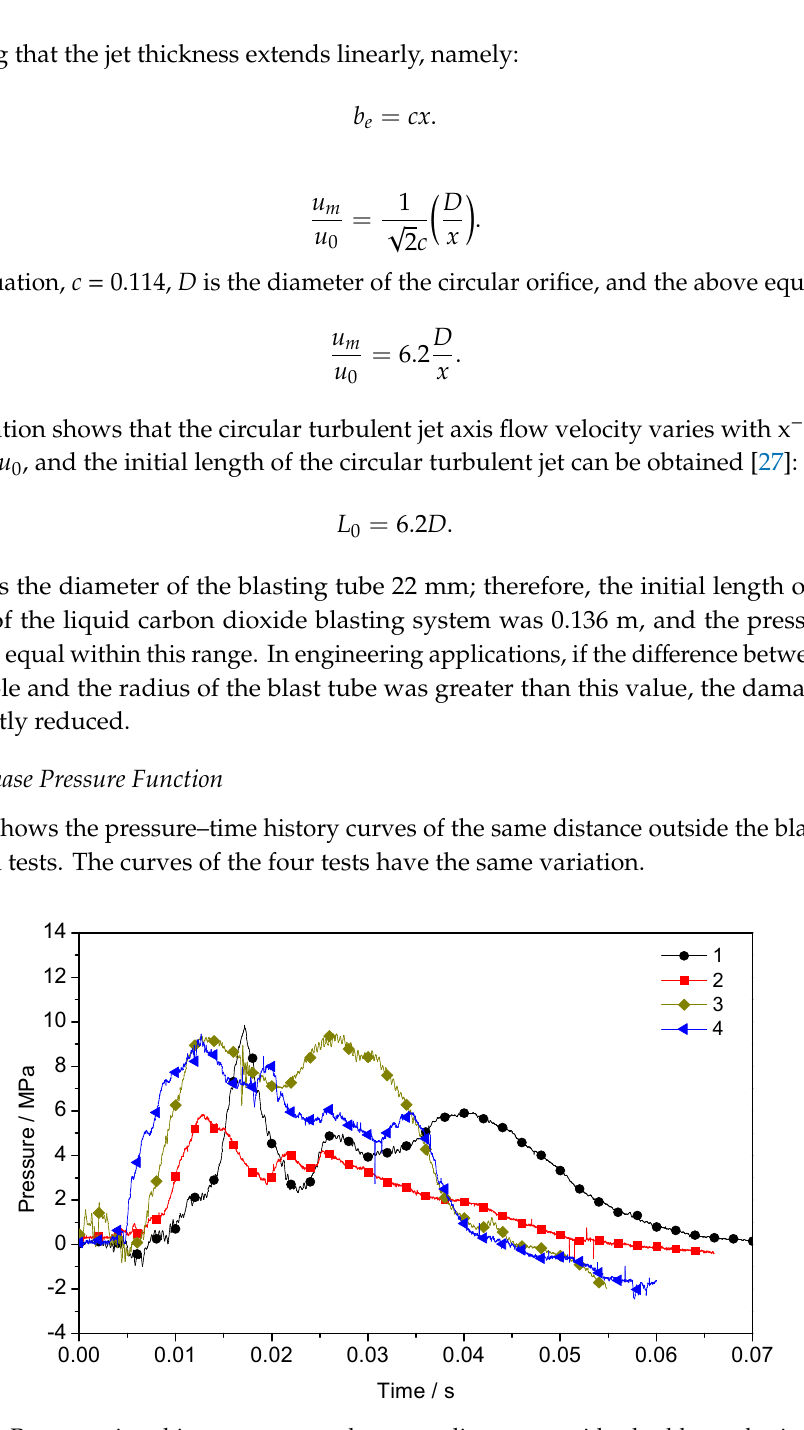
Figure 6. Pressure–time history curve at the same distance outside the blast tube in the four explosion tests.